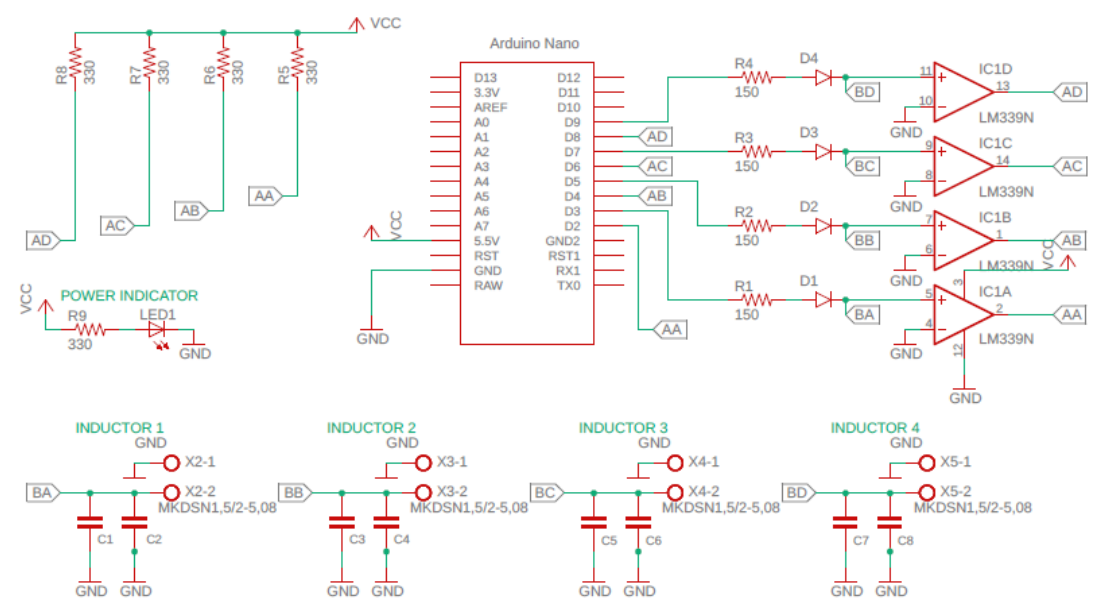
Figure 4. Circuit diagram for the data acquisition system with four inputs.